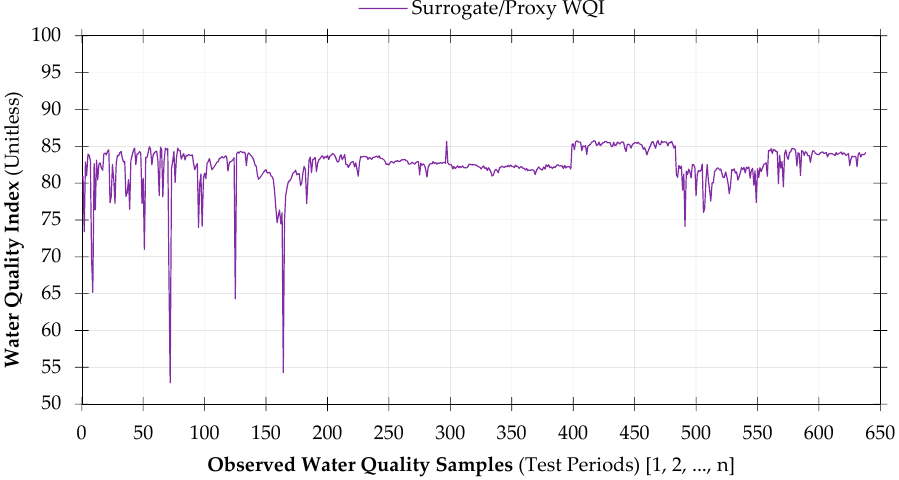
Figure 10. Water quality index results calculated using the proposed surrogate water quality index for Umgeni water quality data for a period of six and half years from January 2012 to July 2018. The Umgeni Dataset is from eight sampling stations which fall under four di ff erent catchment areas namely, Umgeni River catchment (Henley, Inanda and Midmar Dams); Umdloti River catchment (Hazelmere Dam); Nungwane River catchment (Nungwane Dam); and lastly Umzinto / uMuziwezinto River catchment (Umzinto Dam).